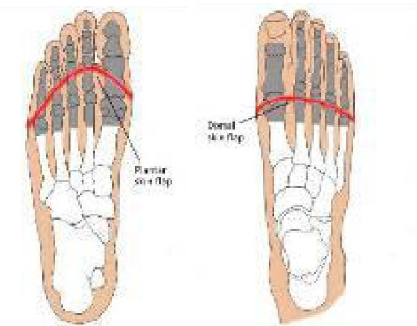
Diagram showing flaps for